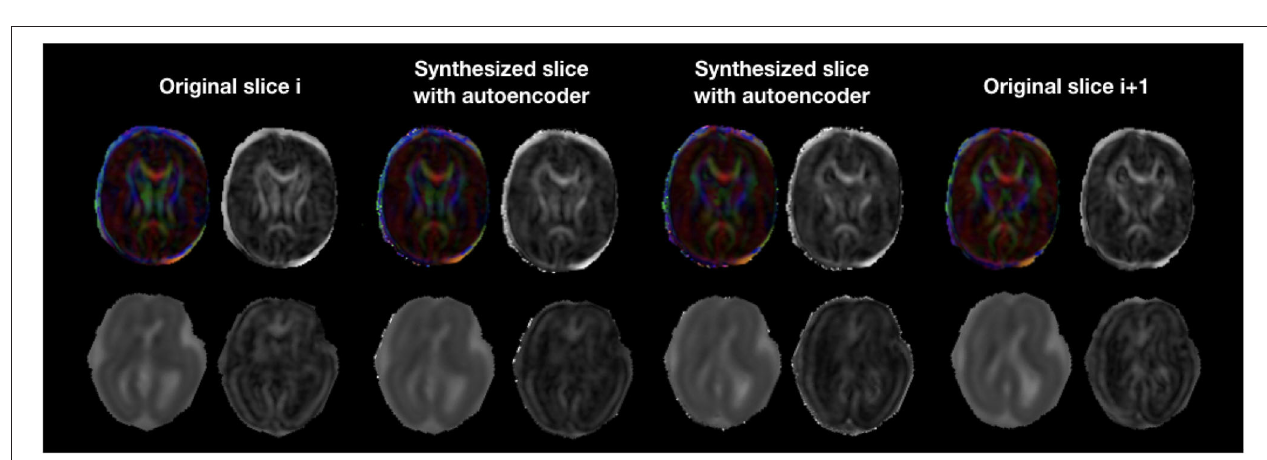
FIGURE 11 | Illustration of inter-volume motion in five different gradient directions of sub-4 ( Table 2 ). Note the severe signal drop in the seventh direction because of motion.